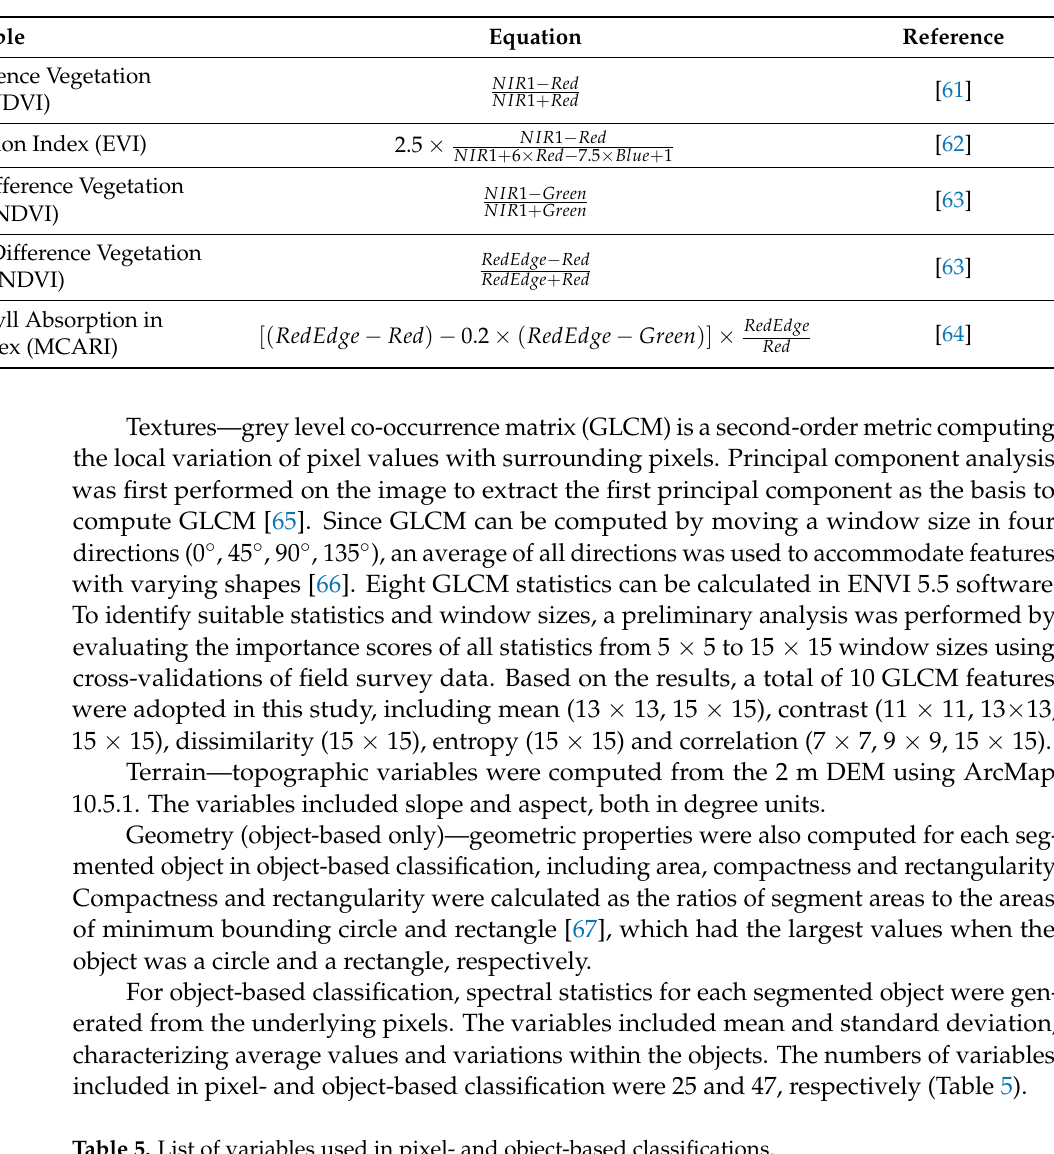
Table 4. Spectral indices used as classification variables.